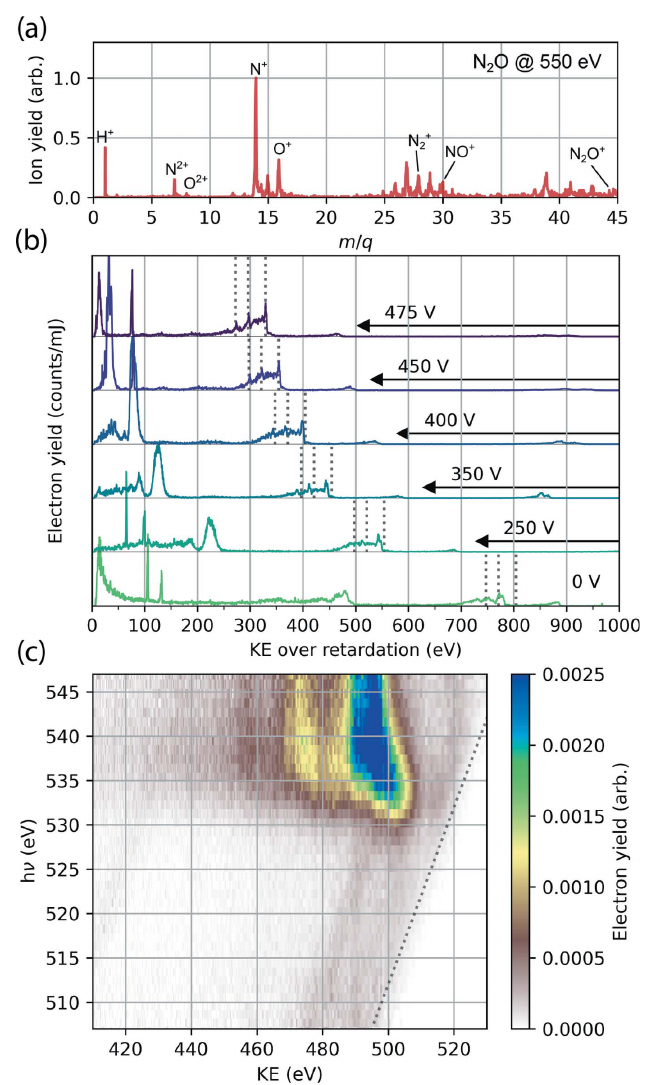
Figure 10 ( a ) Ion mass-to-charge spectrum of N 2 O irradiated by 550 eV X-ray pulses recorded with the magnetic bottle spectrometer. ( b ) Photoelec- trons produced by ionization of Ne atoms by 1.35 keV X-rays, recorded at different retardation voltages applied to the electrostatic lens. As the retardation voltage is increased, the manifold of three primary peaks which form the Ne KLL Auger–Meitner emission spectrum becomes more sharply defined and aligns with previously measured values, as shown by dotted gray lines (Krause et al. , 1970). ( c ) Resonant Auger– Meitner electron emission map of gas-phase 4-aminophenol, recorded with the MBES. Central photon energy of incoming X-ray pulse is plotted on the y -axis and electron kinetic energy is plotted on the x -axis. At photon energies corresponding to the manifold of O 1 s ! valence excitations in the molecule (535 eV) there is a resonant enhancement in the Auger–Meitner electron yield. The emission converges to normal KLL Auger–Meitner decay above the O K -edge at 540 eV. The highest kinetic energy photoelectrons are produced by X-ray ionization of the valence shell and show the expected linear dispersion with photon energy (marked by the dotted